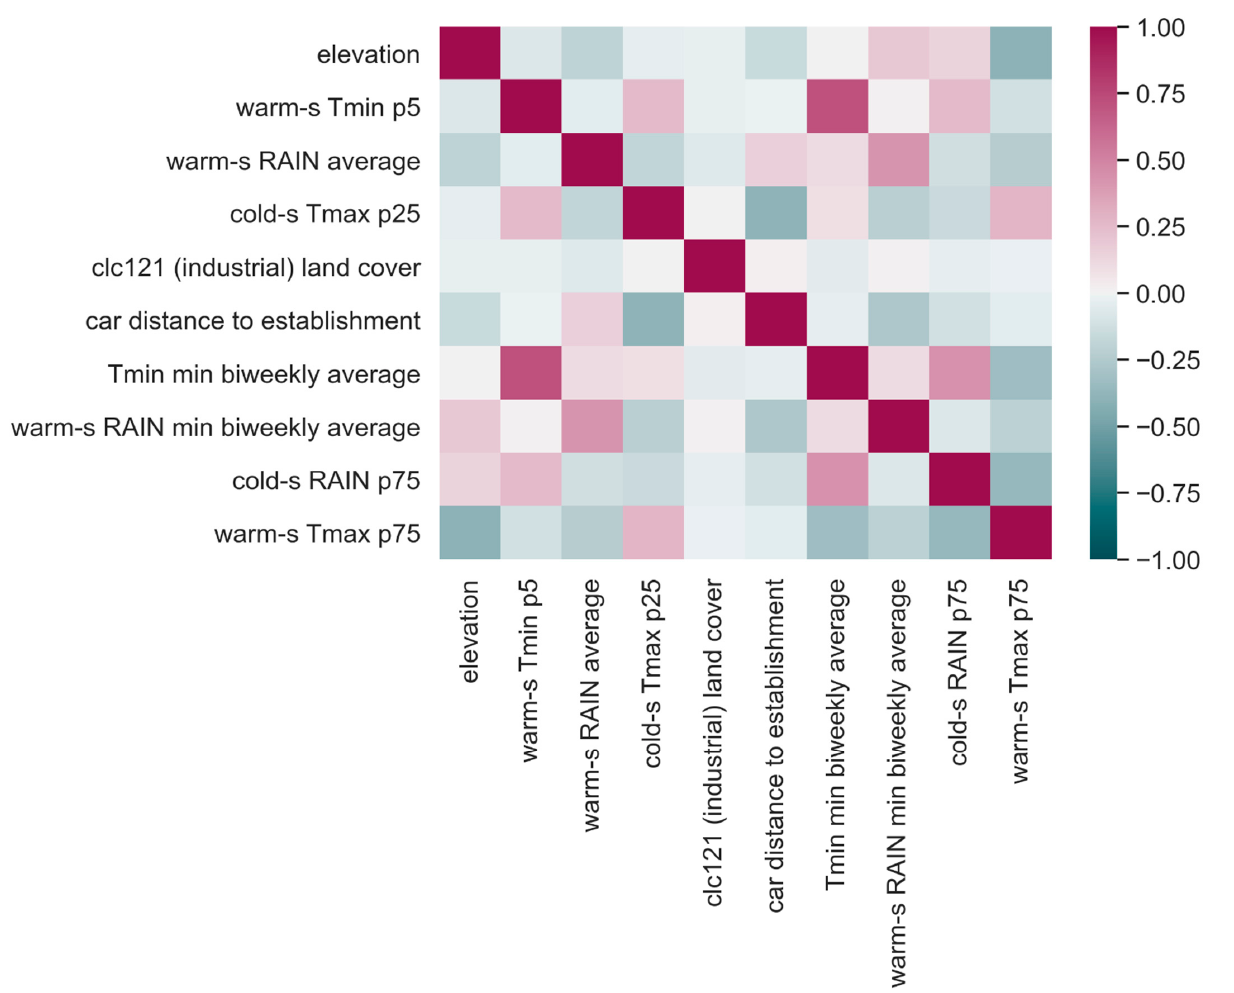
Figure A1. Heatmap of the Spearman’s rank correlation coefficient between predictors selected by the ensemble model.